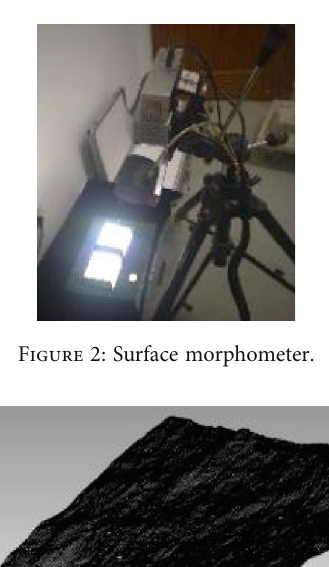
Figure 1: Gneiss discontinuities.